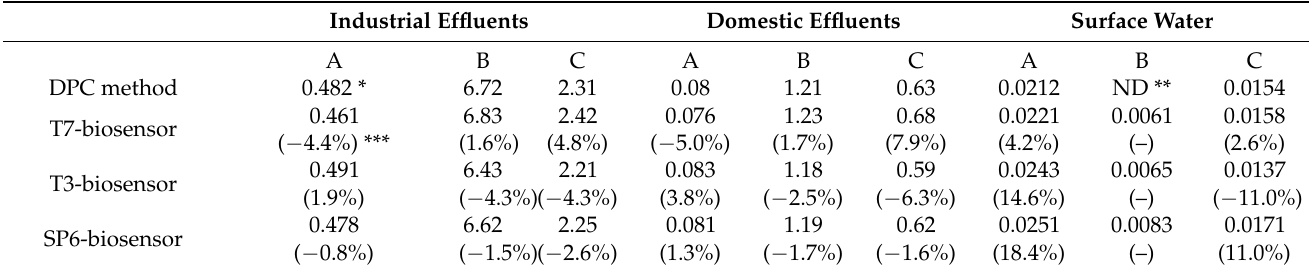
Table 3. Cr(VI) measurement in real water samples by using the colorimetric DPC method and